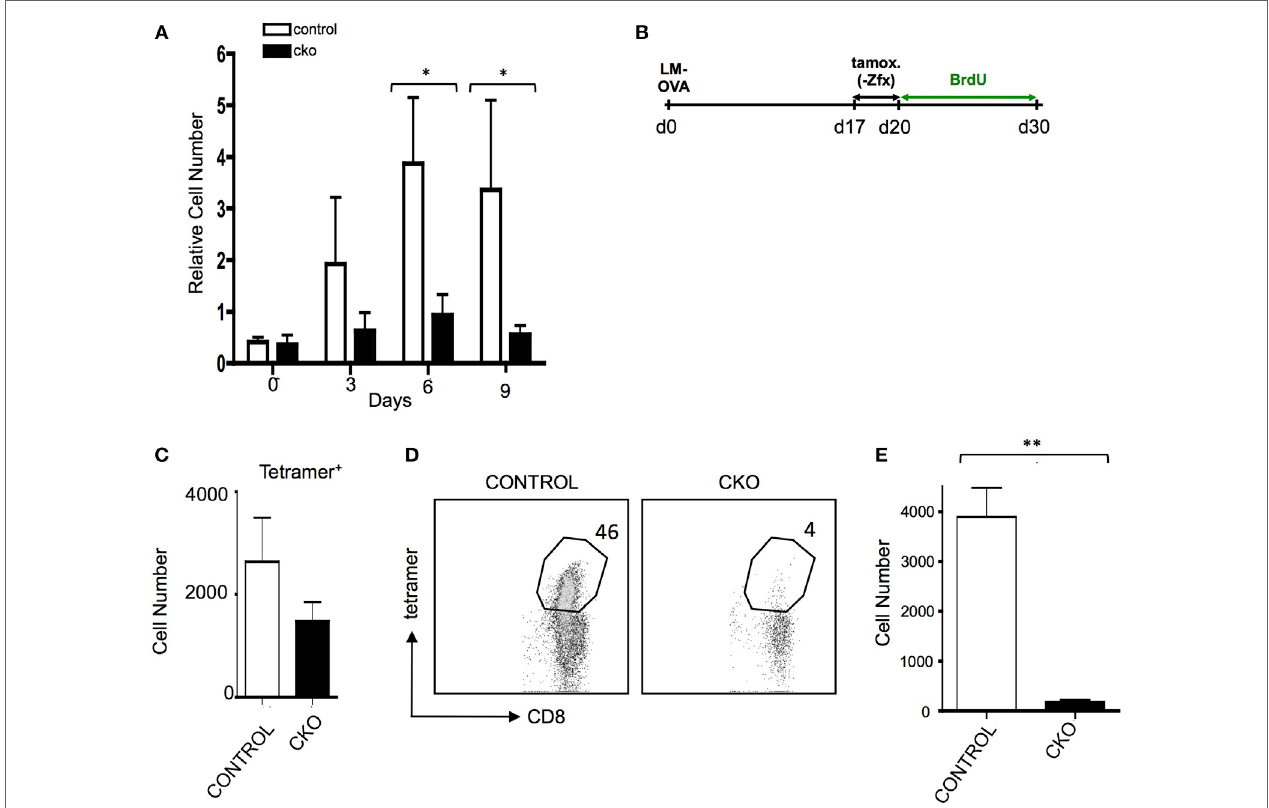
FigUre 4 | Zfx-deficient T cells have a defect in cell turnover and an impairment in recall responses. (a) Memory phenotype (MP) cell expansion in response to IL-15. MACS purified splenic T cells were cultured with 50 ng/mL Il-15. Shown is the relative expansion of control or conditional knockout (CKO) CD8 + CD44 + CD62L + MP cells. Numbers represent the average increase in cell number ± SEM relative to day 0 ( n = 3). * P < 0.05. (B) Experimental layout for figures (c–e) . Control and CKO Rosa26-CreER mice were infected with LM-OVA, and on days 17–19, postinfection administered tamoxifen in order to induce Zfx deletion. On day 20, mice were injected intraperitoneally with bromodeoxyuridine (BrdU) and then administered BrdU in their drinking water for 10 days. Tetramer + and BrdU + cells were tracked as noted in the figures. (c) Formation of memory T cells. Mice were treated according to Figure 4 . Shown is the average ± SEM of tetramer + cells per 1 million splenocytes on day 30, 10 days after Zfx deletion ( n = 2, graph is representative of two independent experiments). (D) Proliferation of memory T cells in response to secondary exposure to antigen. Control and CKO Rosa26-CreER mice were infected with LM-OVA and on days 48–50 administered tamoxifen; on day 52, the mice reinfected with 100-fold more LM-OVA. Shown is the percentage of CD8 + cells in the blood that are tetramer + 4 days after secondary challenge. (e) Quantification of tetramer + memory T cells in the blood 4 days after re-challenge with LM-OVA. Shown is the absolute number ± SEM of tetramer + cells per 100,000 blood cells in control and CKO Rosa26-CreER mice, treated as in (D) . ** P <